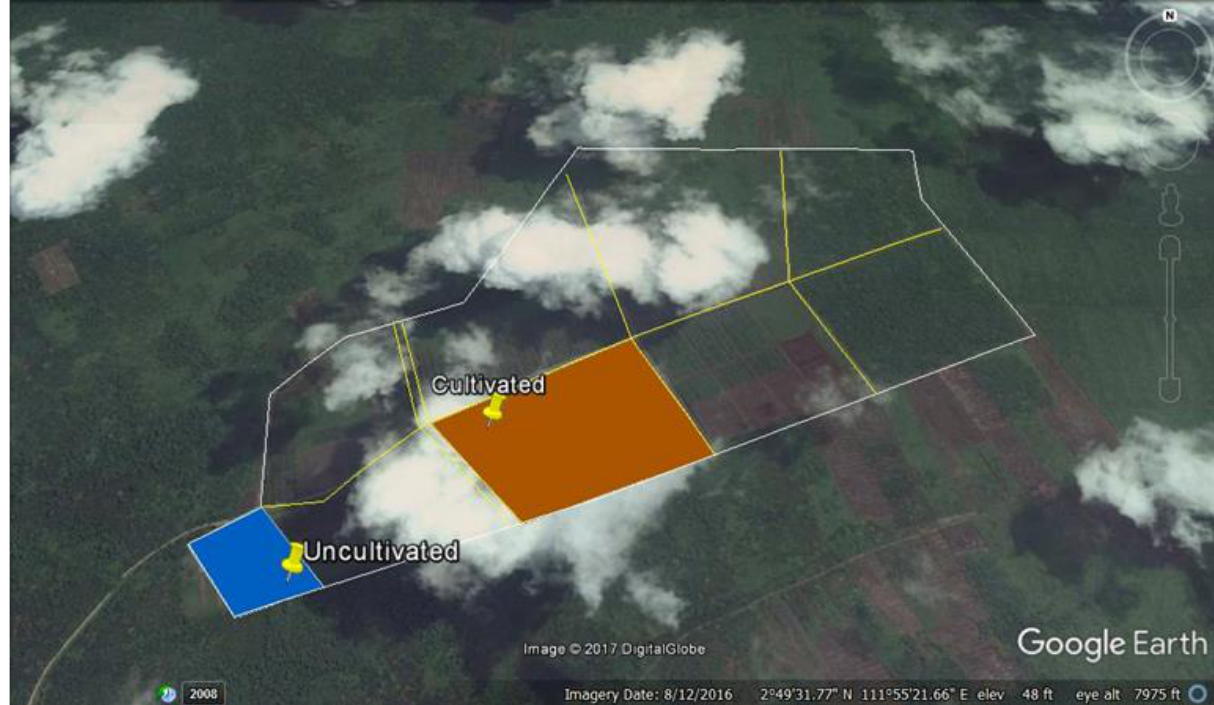
Figure 1. Sungai Talau sago plantation and the sampling